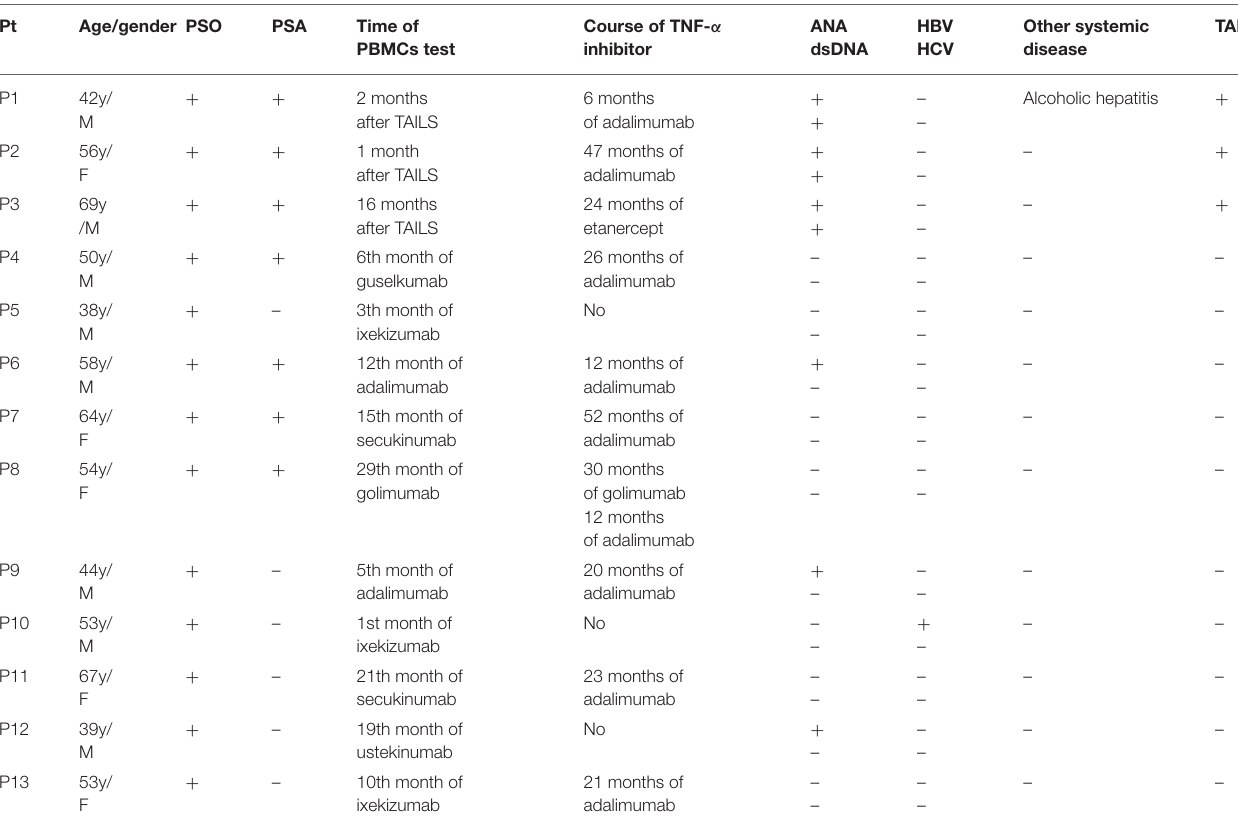
TABLE 1 | Demographic and clinical characteristics of psoriasis patients ( n = 13). Pt